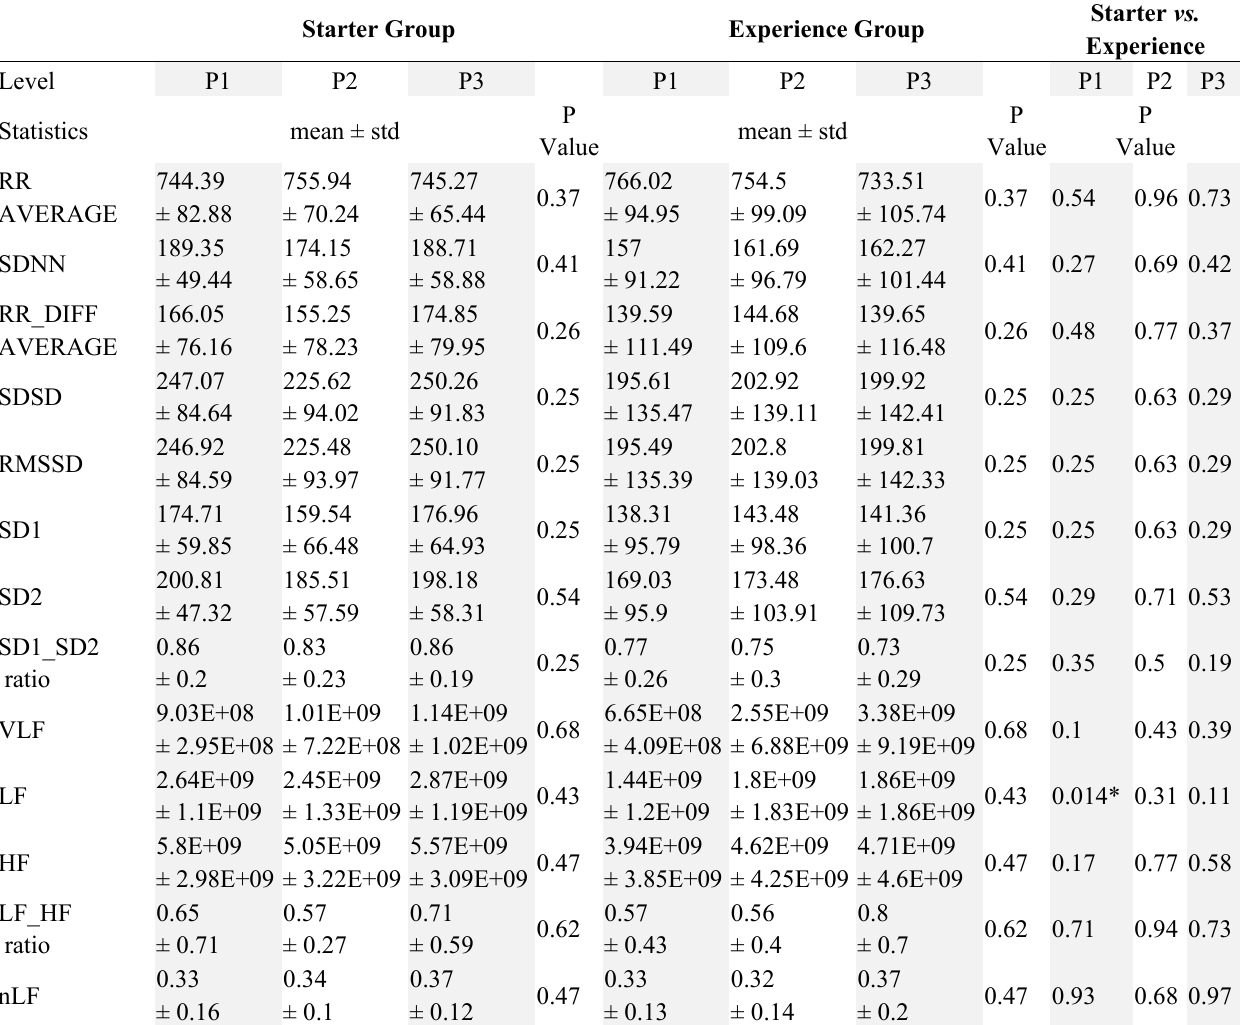
Table 5. Inter and intra group statistical and ANOVA analysis results for three phases on HRV parameters. Data is represented as average (standard